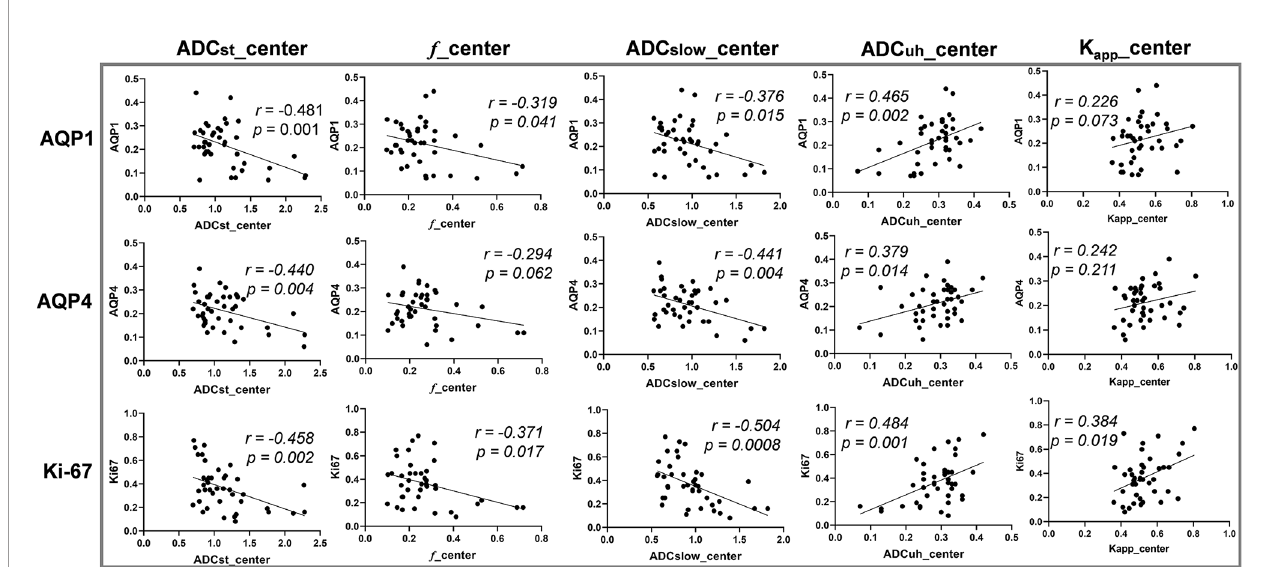
FIGURE 3 | The correlation between diffusion weighted imaging (DWI) parameters and histological indices. Vertical coordinates in rows from top to bottom: AQP1, AQP4 and Ki-67 accordingly. Horizontal coordinates in columns from left to right: ADC st _center, f_center, ADC slow _center, ADC uh _center and K app _center accordingly. Center: parameter measured from tumor